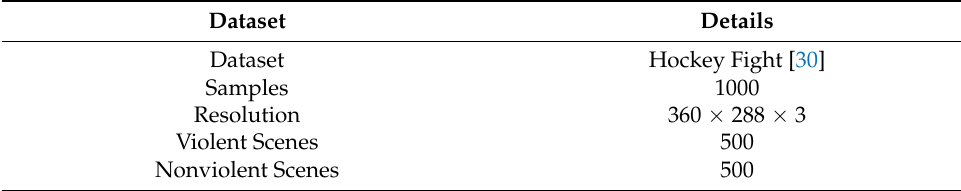
Figure 3. Visual representation of the Hockey Fight and Surveillance Fight datasets. Table 5. Description and statistics of the Hockey Fight